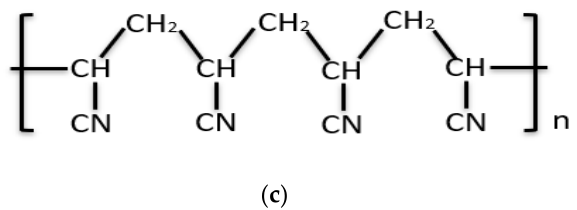
Figure 1. ( a ) The device structure diagram of a red perovskite light-emitting diode (PeLED); ( b ) the device structure diagram of a white PeLED; ( c ) the chemical structure of polyacrylonitrile (PAN).